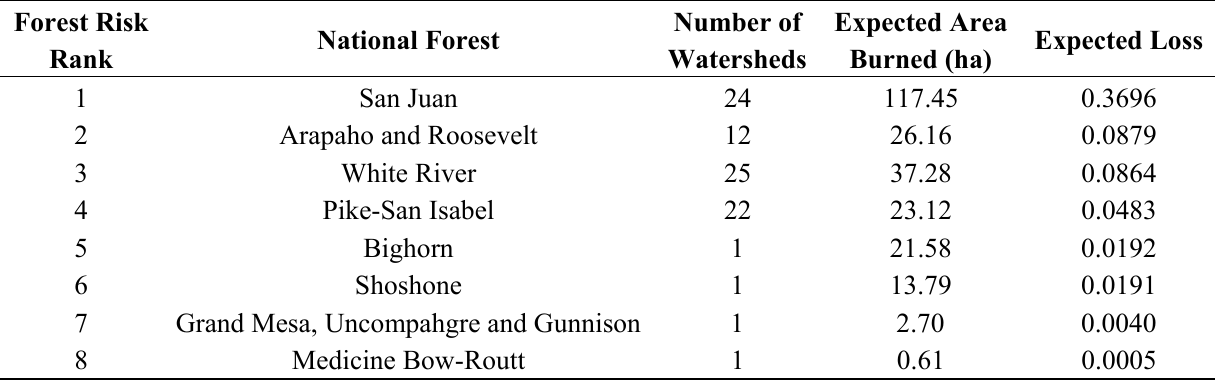
Table 3. The National Forests with the greatest risk to watersheds and water quality, ranked according to expected loss [See Equations (3) and